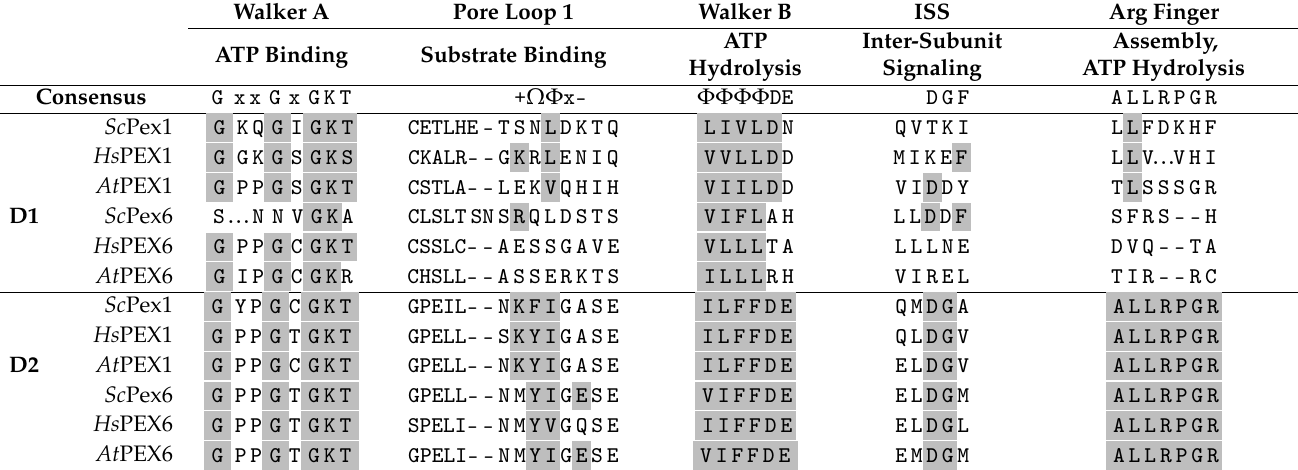
Table 1. Important Motifs for Active AAA-ATPases are Conserved only in Pex1/Pex6 D2 AT- Pase